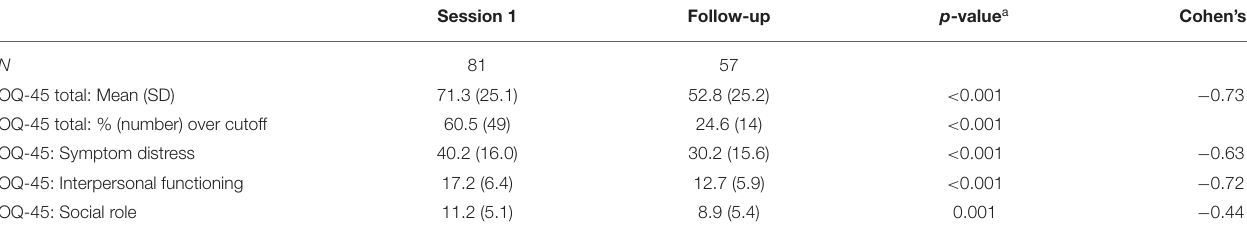
TABLE 4 | Mean levels, and percentages of men scoring above cutoff ( > 63) on clinical distress (OQ-45) at session one and at follow-up. Session